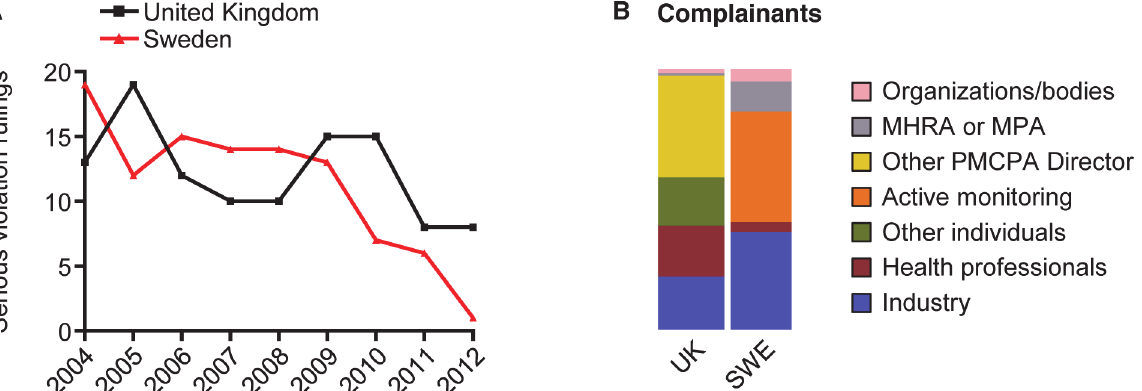
Fig 5. Serious violations in the United Kingdom and Sweden 2004 – 2012: rulings of breach and complainants. (A) Serious violation rulings per year in the UK (total n = 110) and Sweden (total n = 101). (B) shows mosaic plot of the source of the complaint for serious violation rulings in each country over the entire period. A few cases had multiple